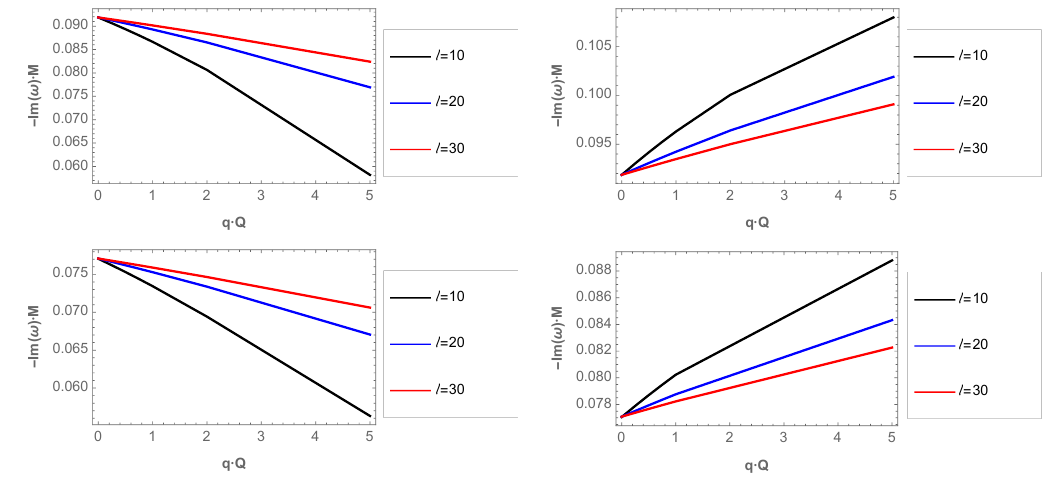
Figure 11 . Behaviour of − Im ( ω ) M as a function of qQ , left panels for the dominant mode n PS = 0 (negative branch), and right panels for the first overtone n PS = 1 (positive branch) for different values of the parameter ‘ = 10 , 20 , 30 , with Λ M 2 = 0 . 01 , mM = 0 . 11 (top panels), and Λ M 2 = 0 . 04 , mM = 0 . 20 (bottom